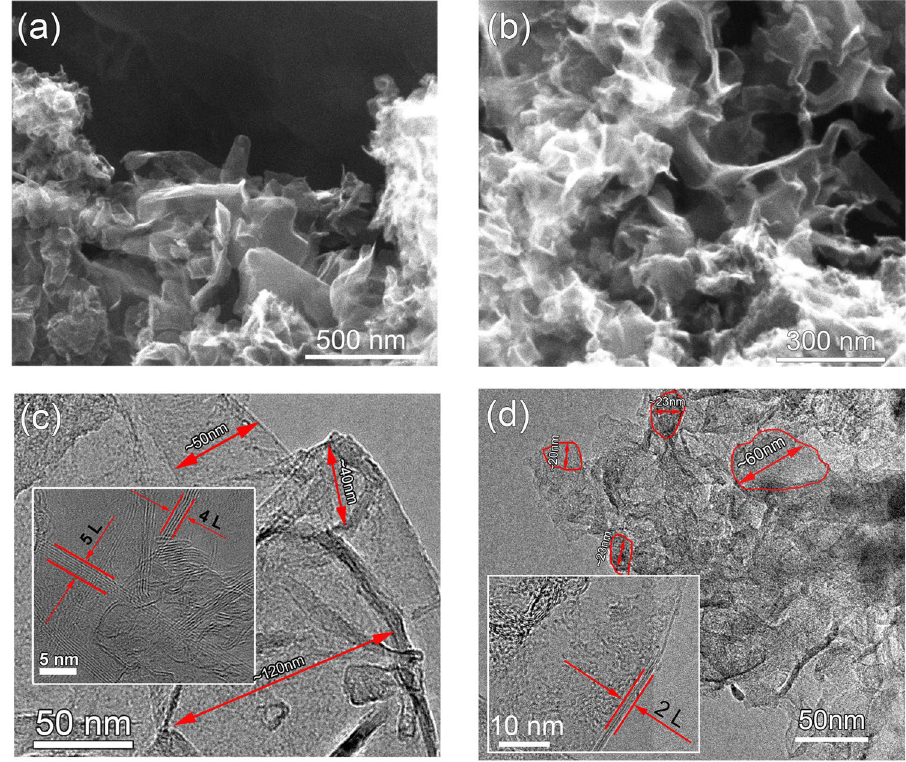
Figure 1. The morphologies of few-layer graphene: ( a ) and ( b ) SEM of M2C1-G and M4C1-G, ( c ) and ( d ) TEM of M2C1-G and